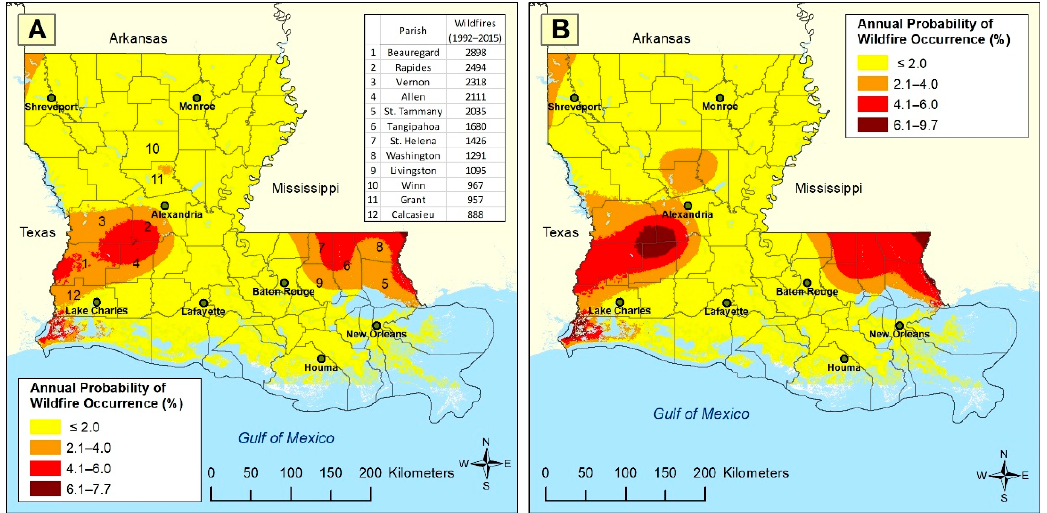
Figure 1. Wildfire burn probability: ( A ) historical (1992–2015), with the top 12 parishes for historical wildfire frequency labeled, and ( B ) projection for 2050.